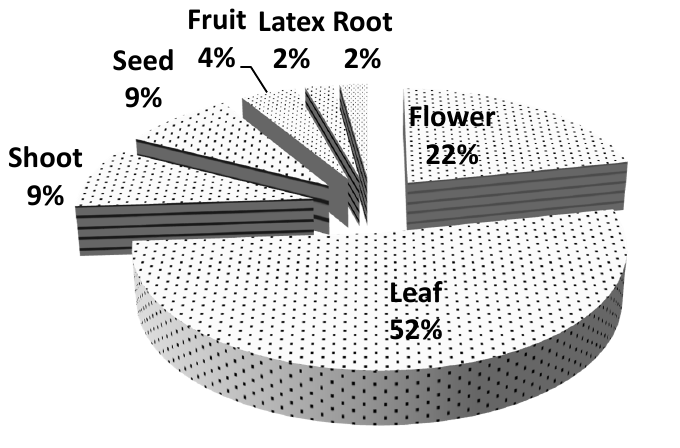
Figure 2. Distribution of plant parts used in taxa